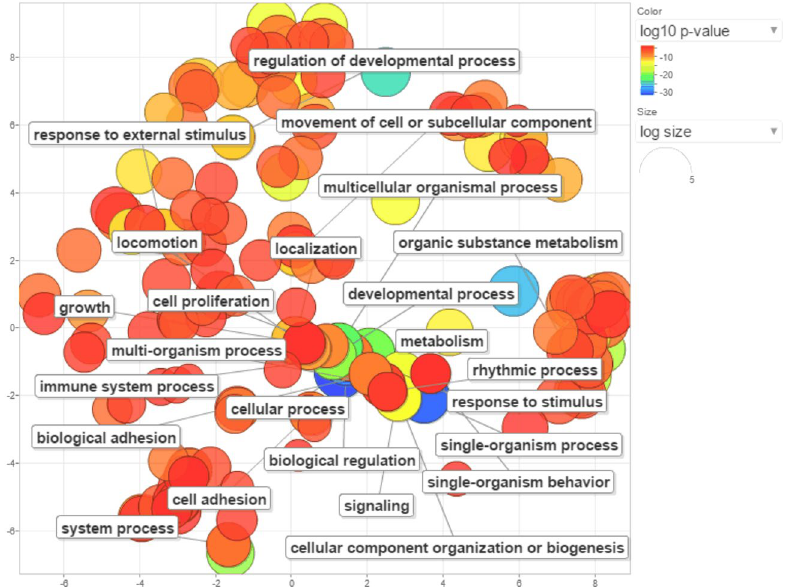
Figure 5. REVIGO scatterplot for GO terms cluster representatives for shared genes up-regulated in POP tissues. Bubble color indicates the user-supplied P - value; size shows the frequency of the GO term in the GO annotation